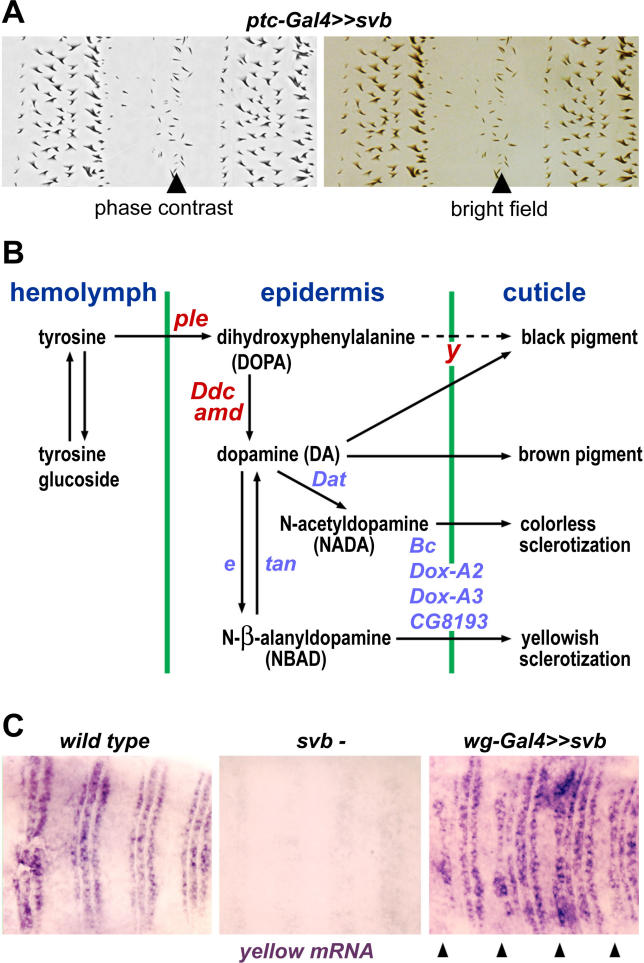

svb Controls Denticle Pigmentation through the Regulation of y Transcription(A) Cuticle preparations (A3–A4 segments) showing the effect of Ptc-Gal4–driven ectopic expression of svb. Ectopic cuticular extensions (arrowheads) are as densely pigmented as normal denticles, as demonstrated by bright-field observation (right).(B) Summary of the cuticular pigmentation pathway, showing genes that are putatively implicated in the transformation of tyrosine to pigmented compounds. Of the ten genes thought to be involved in pigment production we tested, only four (red) are expressed in the embryonic epidermis at the time of cuticle formation.(C) In situ hybridization showing the expression of y mRNA in the epidermis in late embryos. In wild type, y mRNA accumulates in three stripes per segment. Due to deep morphological folds at this stage, it is hard to define accurately the number of cell rows that express y in each segment. y transcription is controlled by svb, since staining is strongly decreased in svb mutant and an ectopic stripe of y mRNA (arrowheads) results from svb ectopic expression in wg cells.